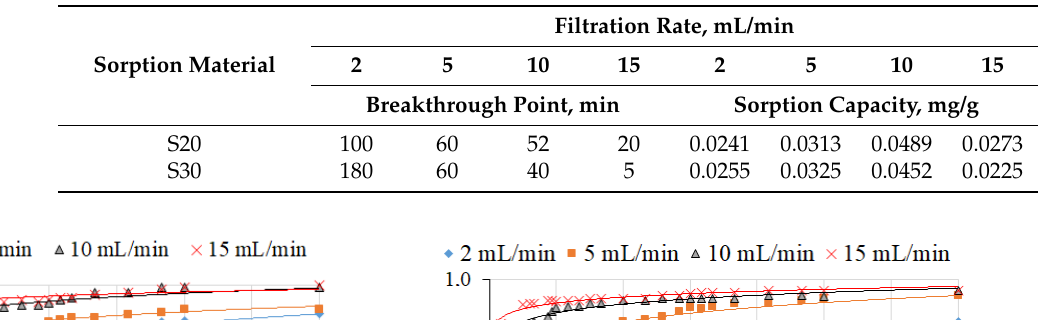
Table 1. The influence of filtration rates on breakthrough point times (min) and NH 4+ sorption capacities (mg/g).